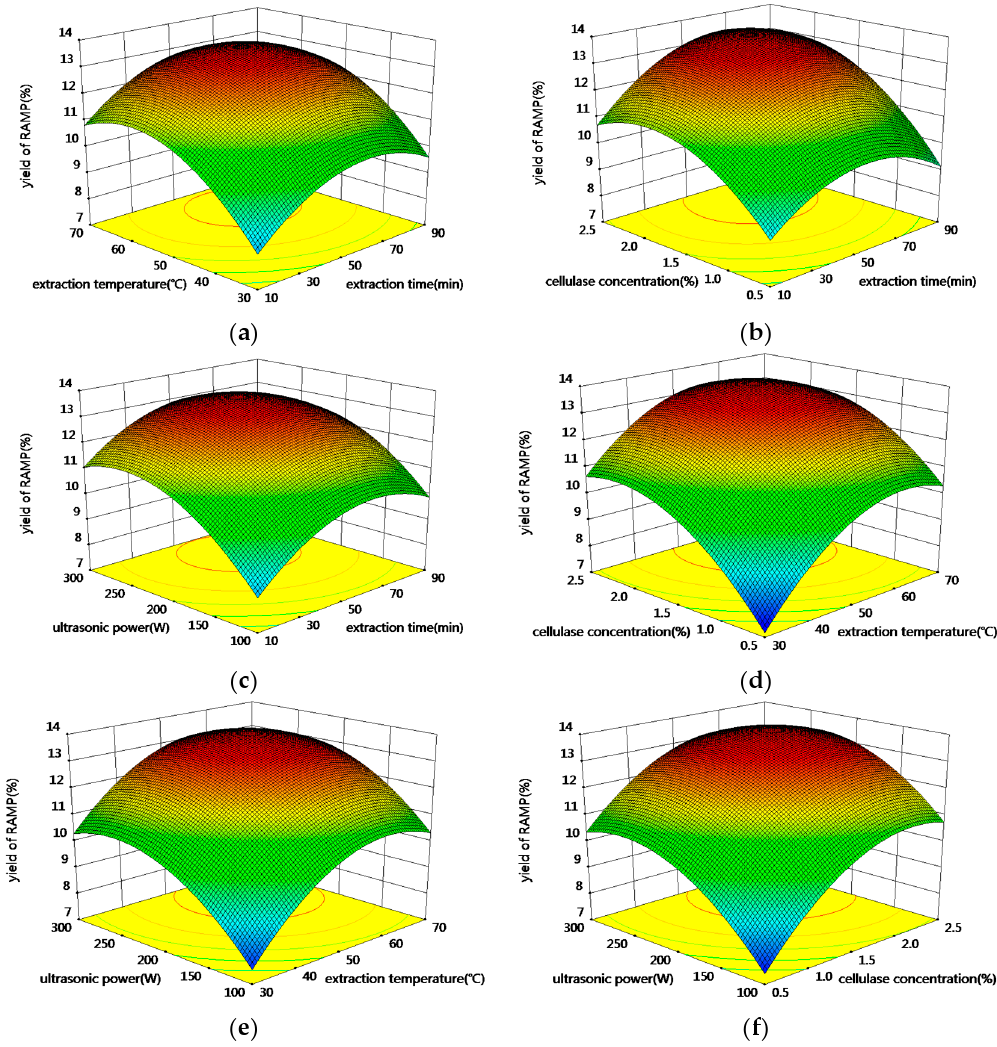
Figure 2. Response surface (3D) showing the effect of extraction parameters on extraction yield of RAMP. ( a ) extraction time and temperature; ( b ) extraction time and cellulase concentration; ( c ) extraction time and ultrasonic power; ( d ) extraction temperature and cellulase concentration; ( e ) extraction temperature and ultrasonic power; ( f ) cellulase concentration and ultrasonic power.